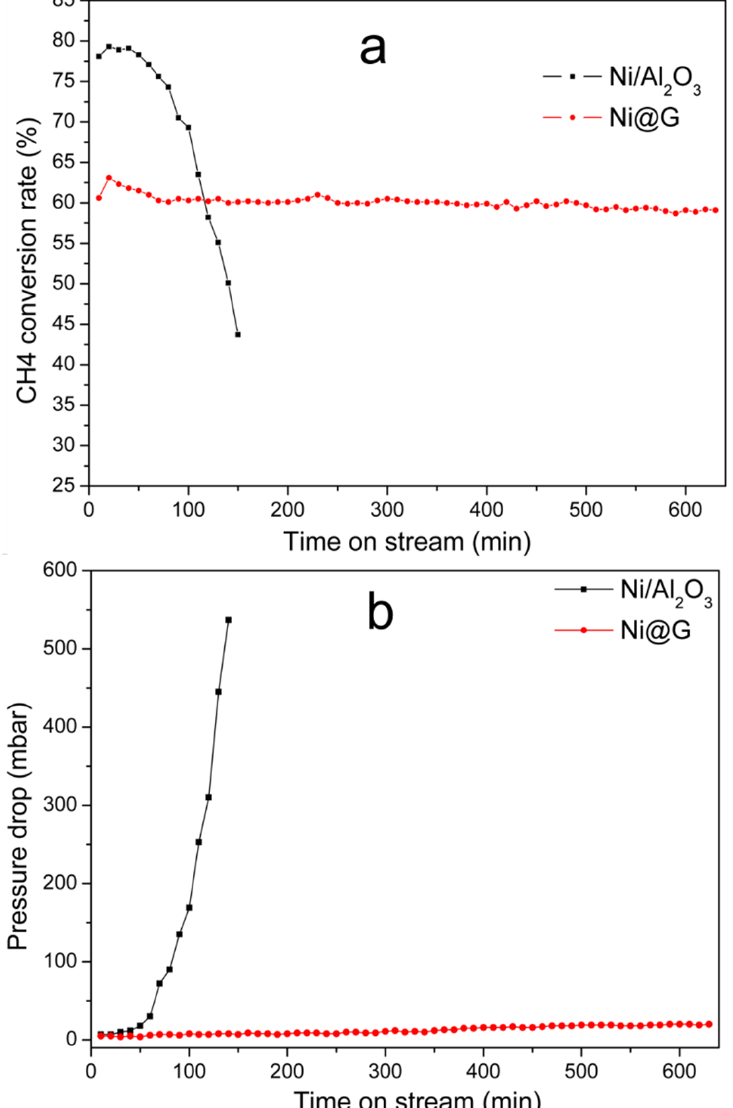
Figure 9. Comparison of 25.5% Ni@G and 10% Ni/Al 2 O 3 for CDM reaction: ( a ) CH 4 conversion rate (%) and ( b ) pressure drop across the catalyst bed. Reaction conditions: 800 °C; catalyst used: 10 g; (%) and ( b ) pressure drop across the catalyst bed. Reaction conditions: 800 ◦ C; catalyst used: 10 g; gas flow rate: 100 mL/min. gas flow rate: 100